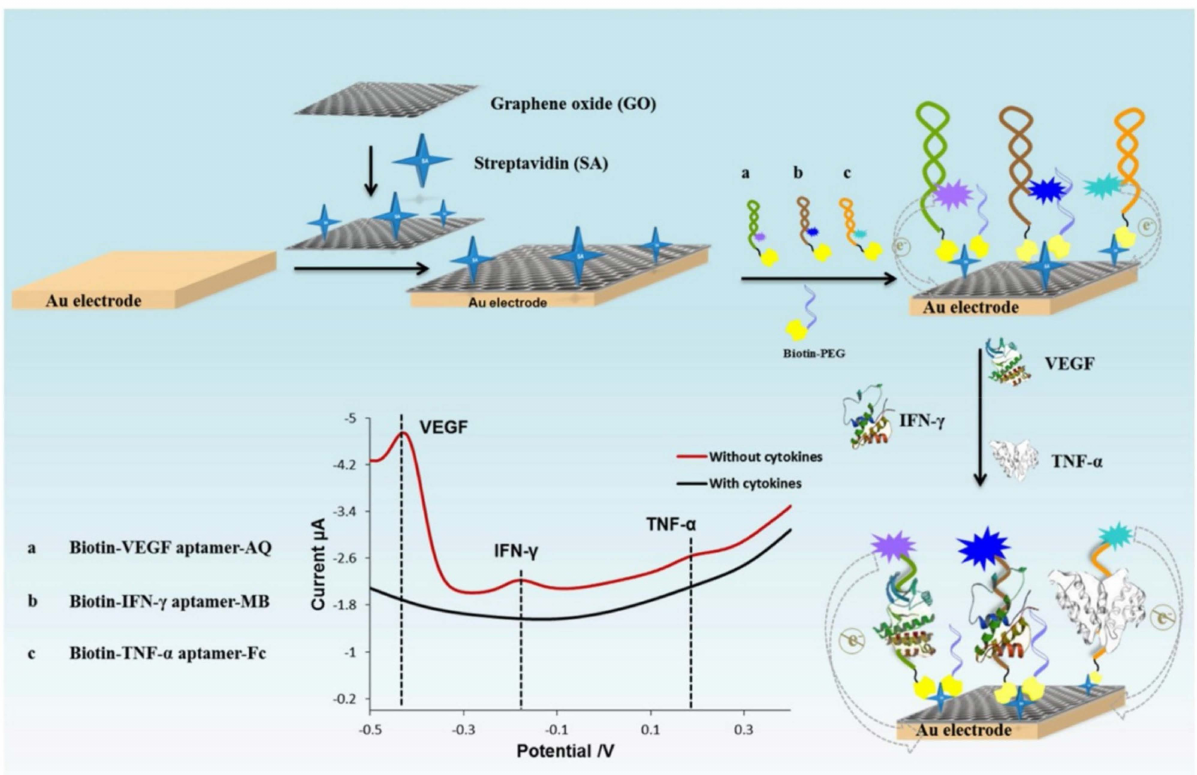
Figure 2. The scheme of simultaneous determination of VEGF, IFN- γ , and TNF- α using an electro- chemical aptasensor labelled with redox markers aptamers (reprinted with permission from Shen et al. 2021